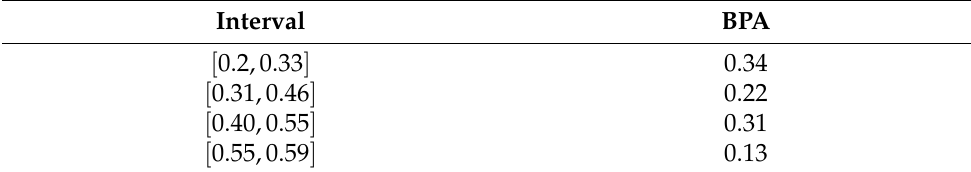
Table 2. Intervals and basic probability assignments (BPAs) of ξ 2 from Source